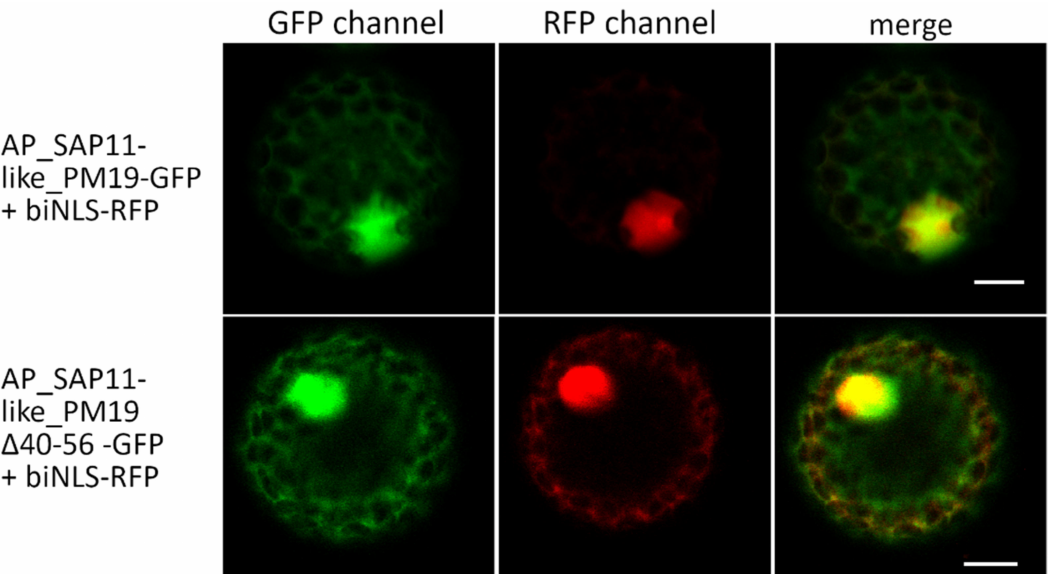
Figure 3. Localization studies of AP_SAP11-like_PM19 protein in protoplasts of infiltrated N. benthamiana leaves. AP_SAP11- like_PM19 and AP_SAP11-like_PM19 ∆ 40–56 were fused to GFP and biNLS with RFP to decorate the nucleus. The localization of expressed proteins was analyzed by confocal microscopy using GFP and RFP filters. AP_SAP11-like_PM19 (SAP11-GFP) and AP_SAP11-like_PM19 ∆ 40–56 ( ∆ NLS-SAP11-GFP) localize not only in the plant nucleus but also in the cytoplasm. Co-localization with biNLS-RFP is indicated by yellow coloring in the merge. Scale bar = 10 µ